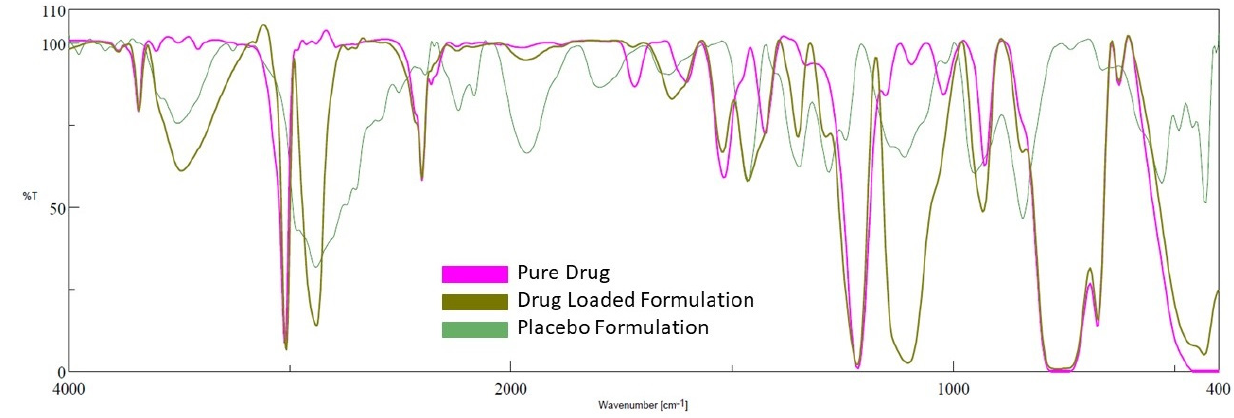
Figure 8. FTIR spectra of darunavir, placebo, and in situ gel formulation (D7).